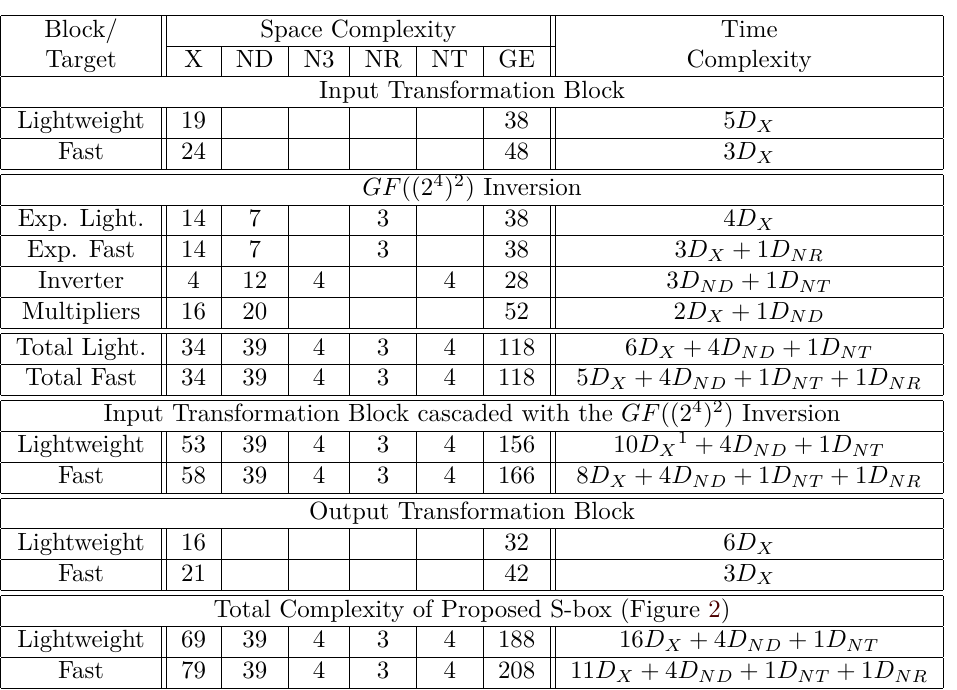
(NAND2)=1 GE, 3-input NAND gate (NAND3)=1.25 GEs, 2-input NOR gate (NOR2)=1 GE, and a NOT gate=0.75 GEs. Table 5: Space and time complexities for different blocks and the GF ((2 4 ) 2 ) inversion of the entire proposed S-box architecture shown in Figure 2 (X=XOR2/XNOR2, ND=NAND2, N3=NAND3, NR=NOR2, NT=NOT, 1X= 2GEs, 1ND=1NR= 1GE, 1N3= 1.25GEs, 1NT=